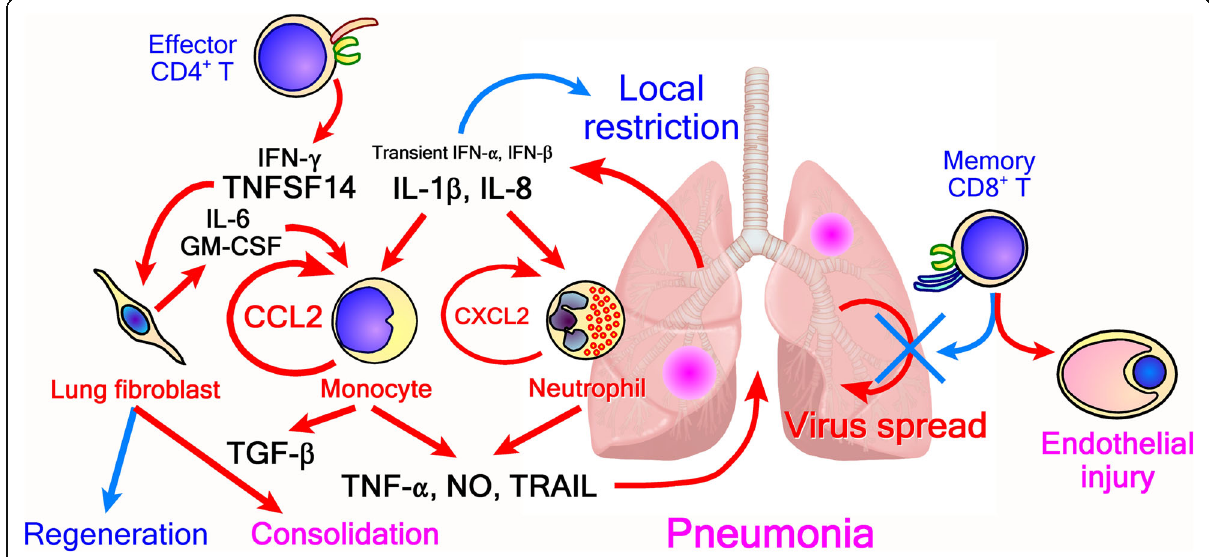
Fig. 4 Schematic representation of the pathogenesis of SARS-CoV-2-induced lung injury. See the main text for a detailed